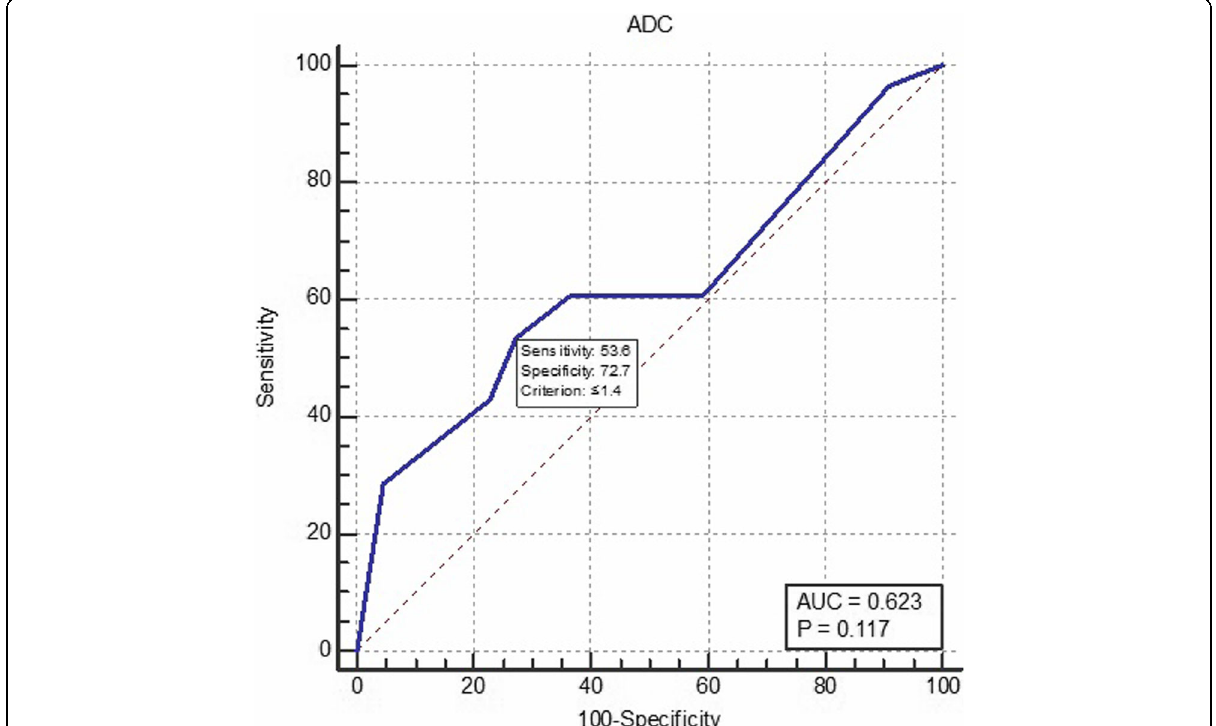
Fig. 5 ROC curve shows the performance of ADC for differentiating clear RCC from non-clear RCC (selection of 1.4 × 10 − 3 mm 2 /s as a cutoff point of ADC value revealed an AUC of 0.62, sensitivity of 53.6%, and specificity of 72.7 %)